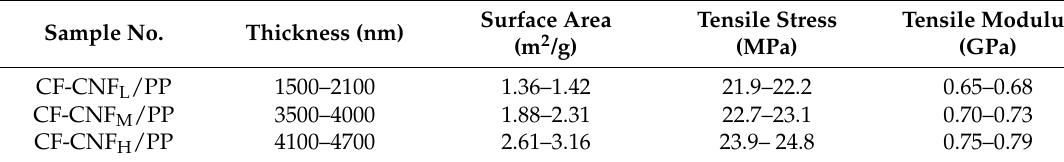
Table 5. Tensile data for different thickness of CNF in CF-CNF/PP composite. Sample